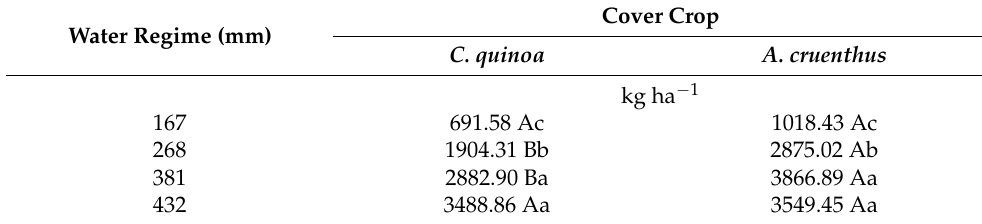
Table 5. Interaction between water regimes and cover crops in grain yield under four water regimes. Water Regime